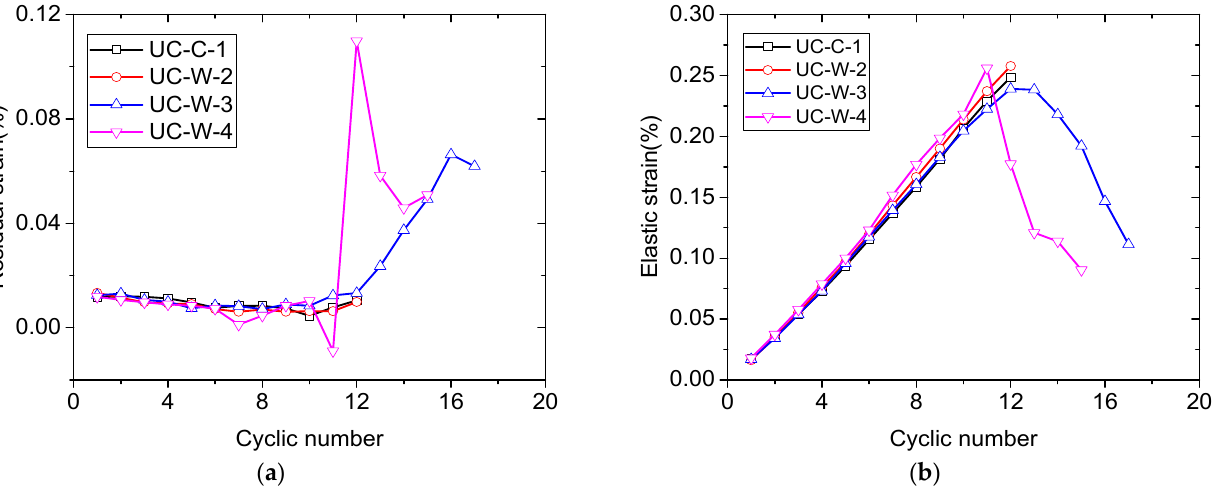
Figure 12. Variations of the residual strain and elastic strain with number of cycles: ( a ) relationship between residual strain and cycle number and ( b ) relationship between elastic strain and number of cycles.